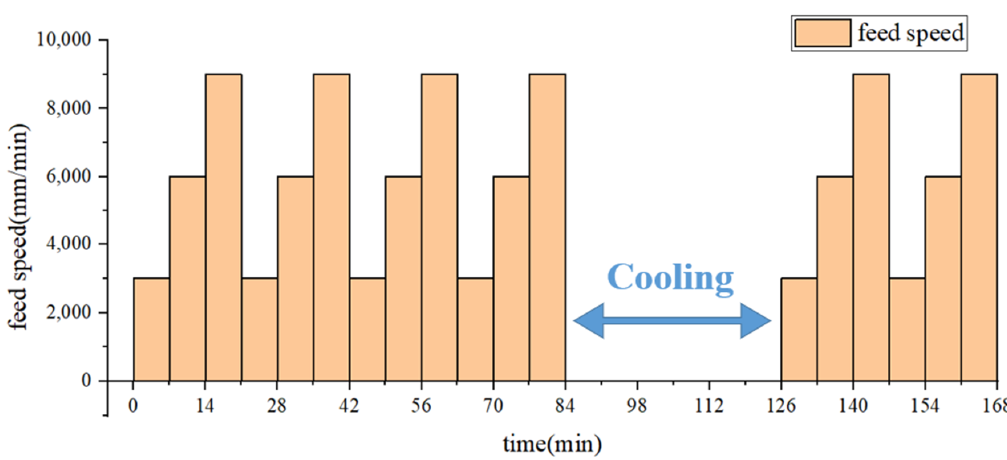
Figure 12. Simulated loading for verification experiment.